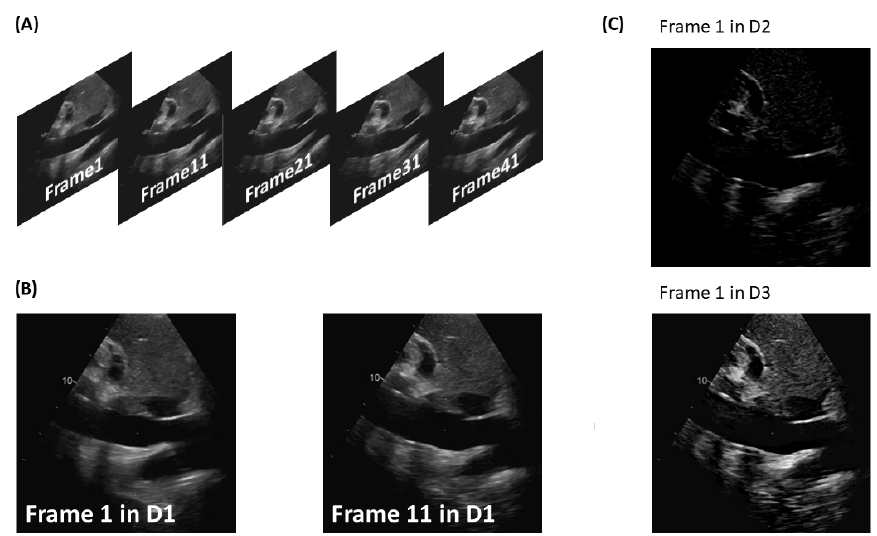
Figure 1. Process of creating the augmented datasets. ( A ) Frames extracted from a US video and segmented by the operator. ( B ) Example of a pair of consecutive frames. ( C ) Examples of images included in the two datasets obtained applying Equation (1): dataset 2 provides information on IVC movement; dataset 3 includes images including both information on the anatomy and on the movement of tissues. Algorithm 1: An n -dimensional array (where n is the number of subjects) con- taining integer numbers (indicating the number of frames from each subject) is subdivided into k groups ( k − 1 used for training and one for testing) with n multi- ple of k , by minimizing the differences of the sum of the numbers in each group (i.e., their available